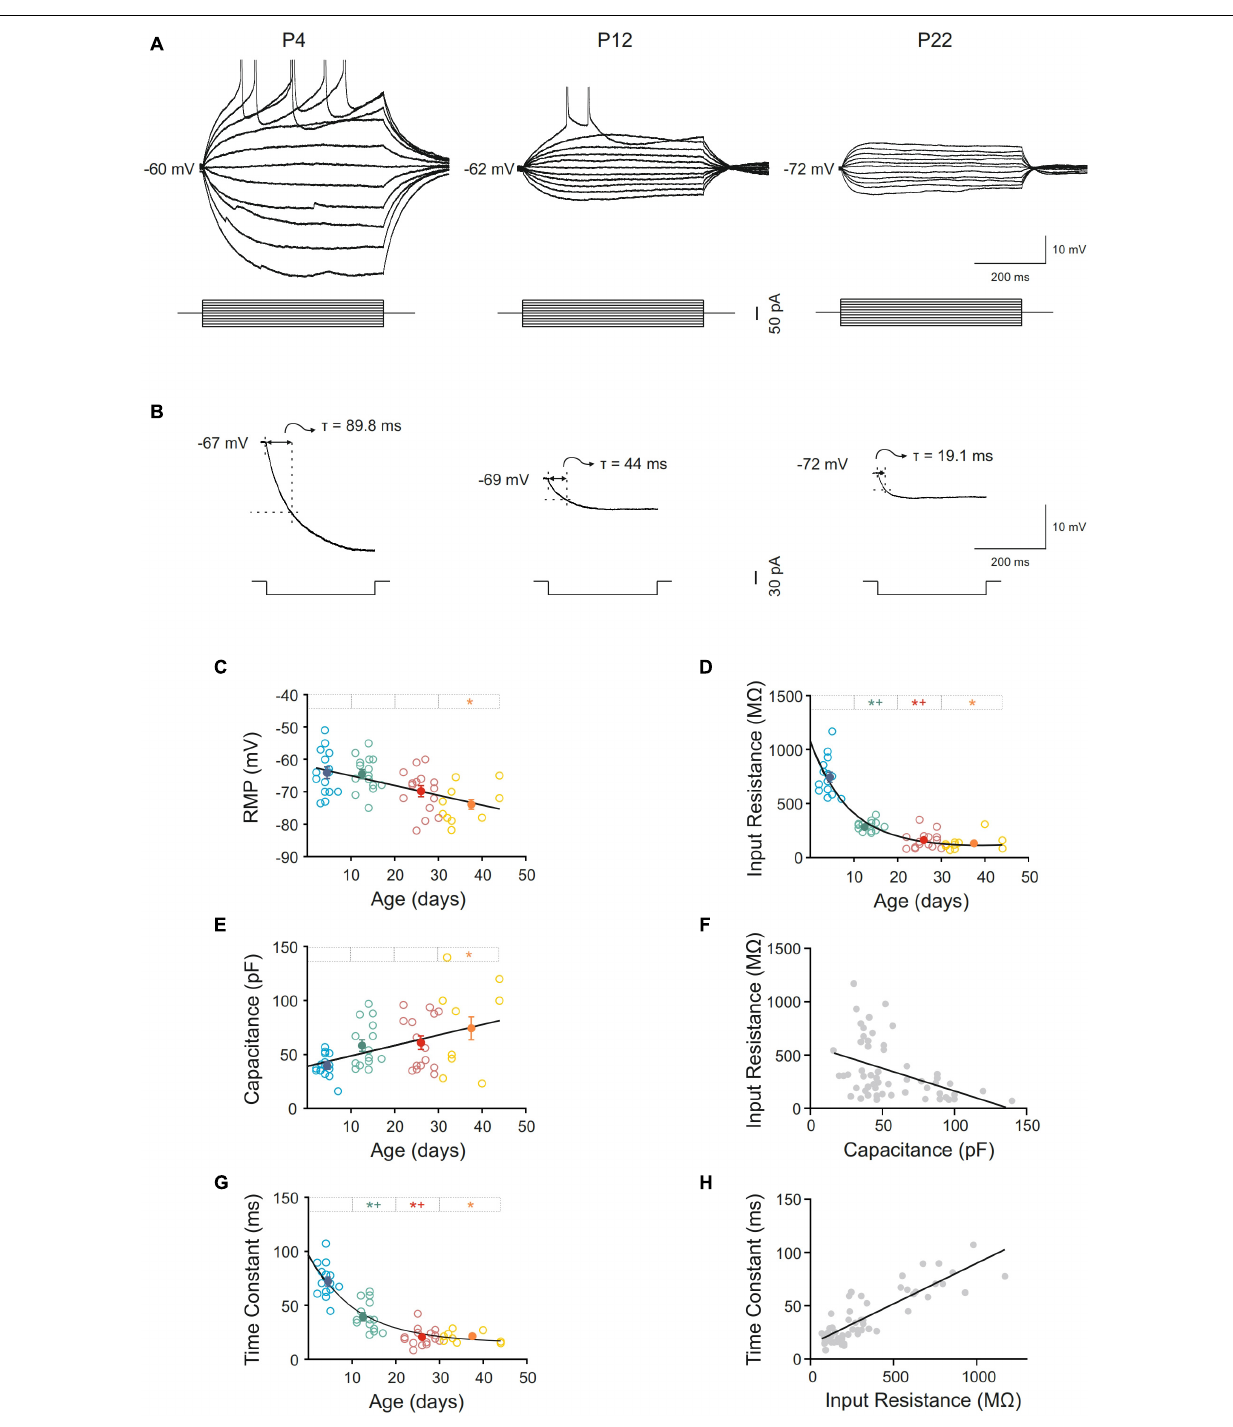
Frontiers in Molecular Neuroscience |